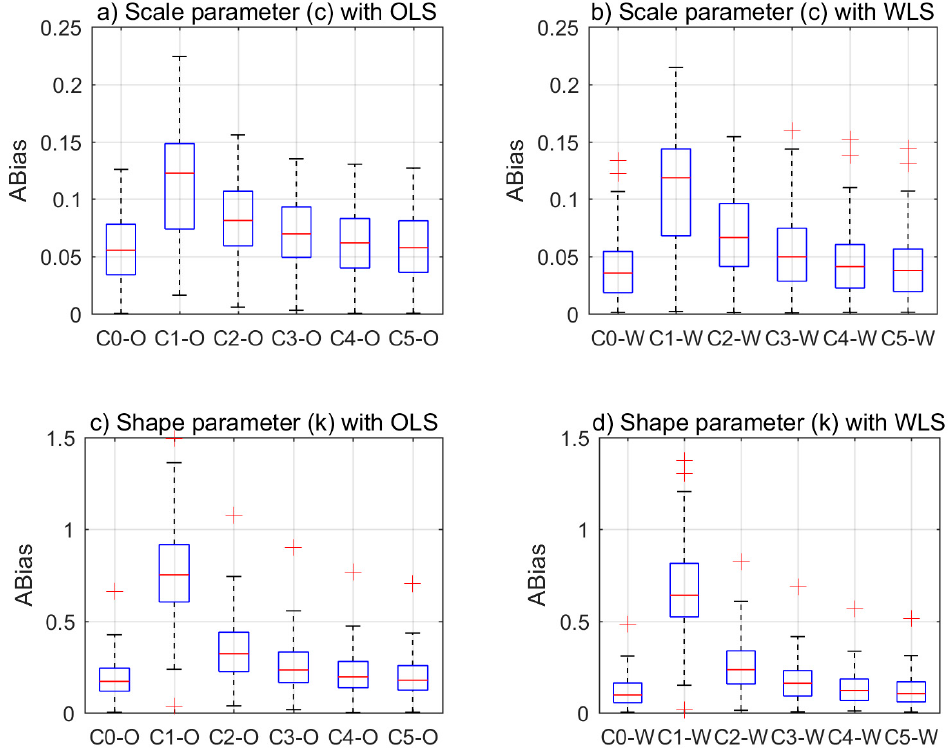
Figure 5. Boxplots of ABias of scale (c) and shape (k) of the downscaled Weibull distribtuion with the OLS and WLS methods based on the parameter estimates from the observed Weibull distribution. Note that ( a ), ( b ), ( c ) and ( d ) presents boxplots of scale parameter estimates with OLS, scale parameter estiamtes with WLS, shape parameter estimates with OLS, and shape parameter with WLS, respectively.